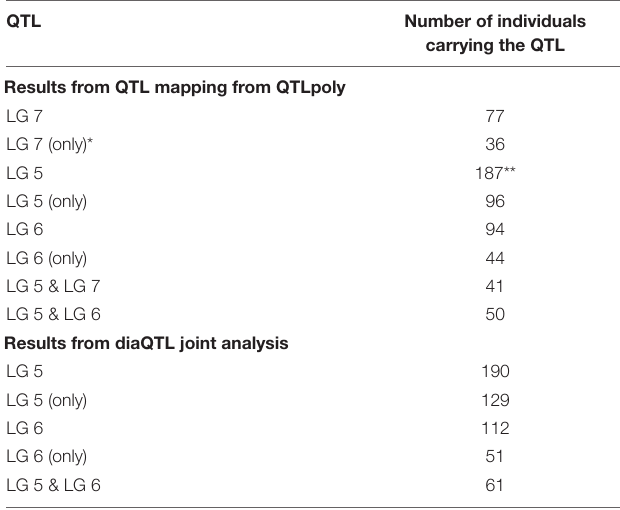
TABLE 4 | Individuals from two biparental tetraploid garden rose mapping populations carrying quantitative trait loci (QTL) for rose rosette disease (RRD)